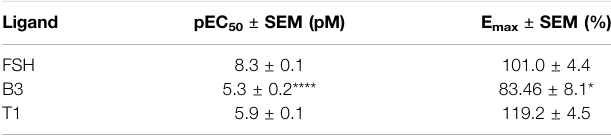
TABLE1| Potency(pEC50)andef fi cacy(E max )displayedbyFSH,B3andT1inBRET CAMYEL assays. Ligand pEC 50 ± SEM (pM) FSH